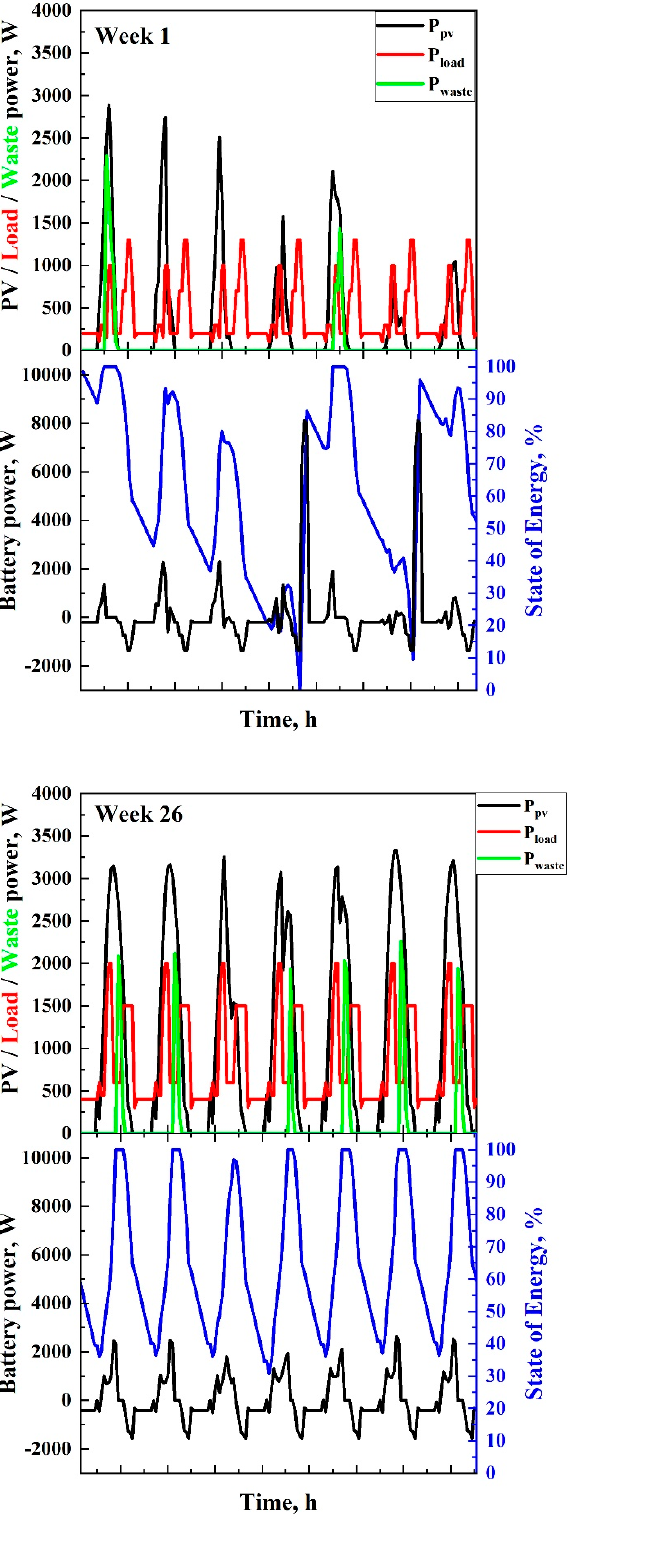
Figure 7. System performance using lithium-ion battery.